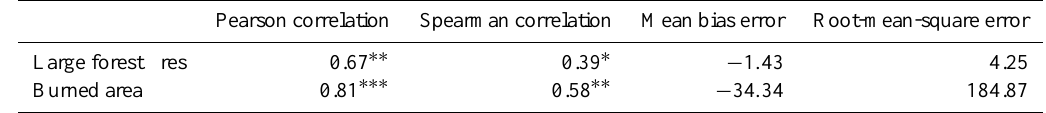
Table 3. Statistics for the model validation over the period 1996–2014.